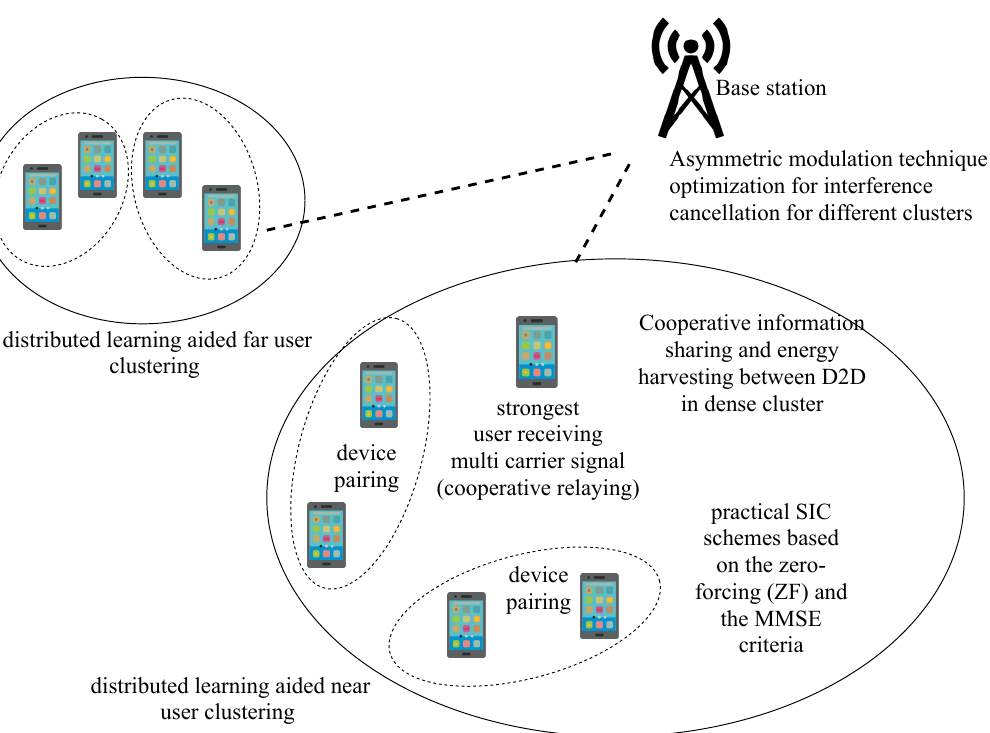
Figure 10. Incooperating several emerging energy efficient techniques together to achieve energy efficiency in NOMA based wireless